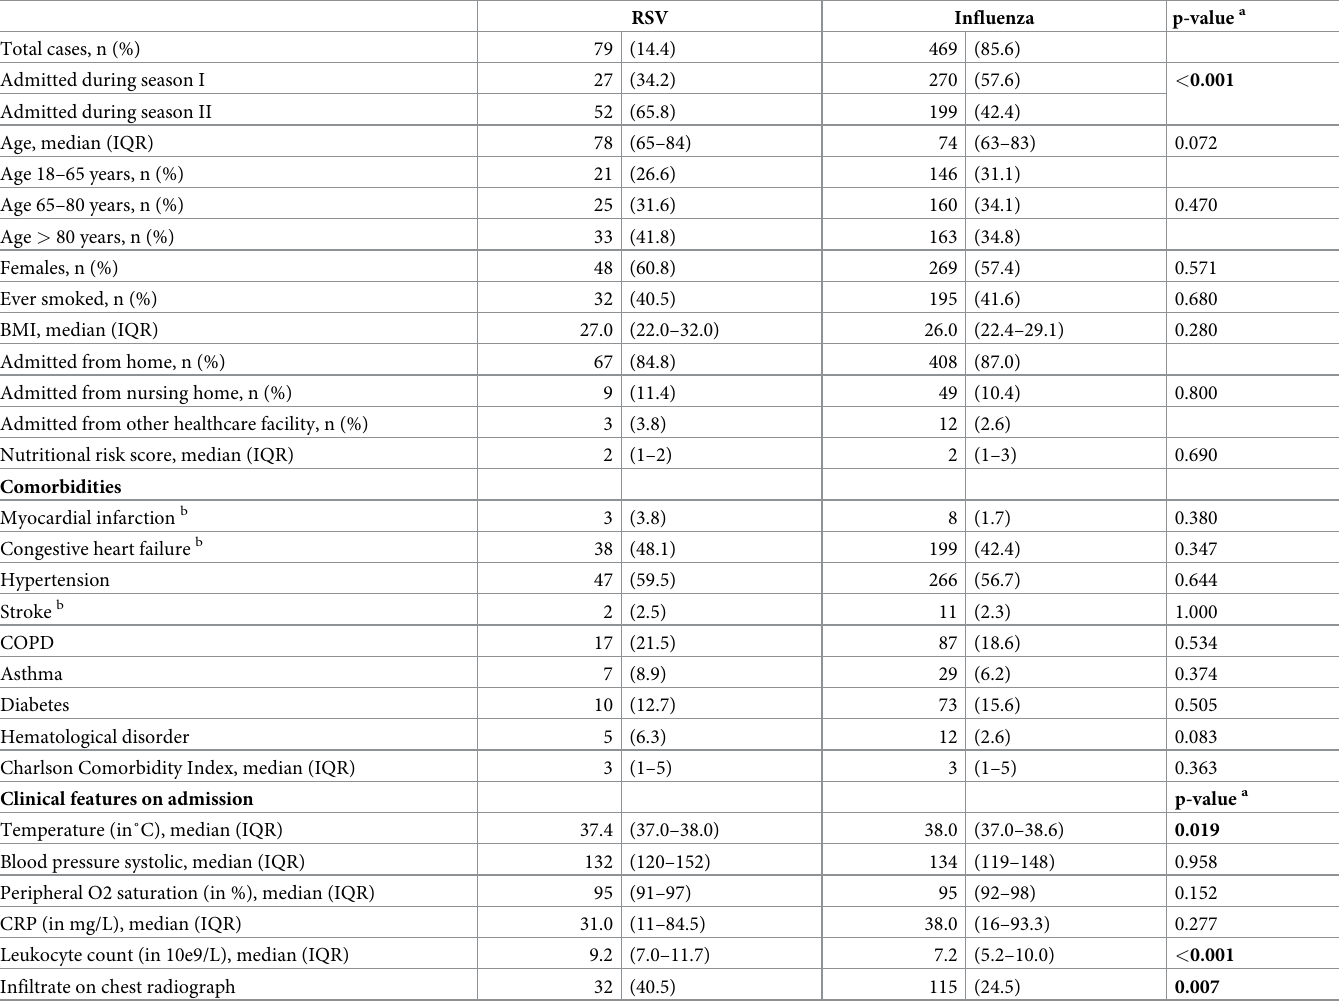
Table 1. Characteristics of patients with laboratory confirmed RSV or influenza virus infection on